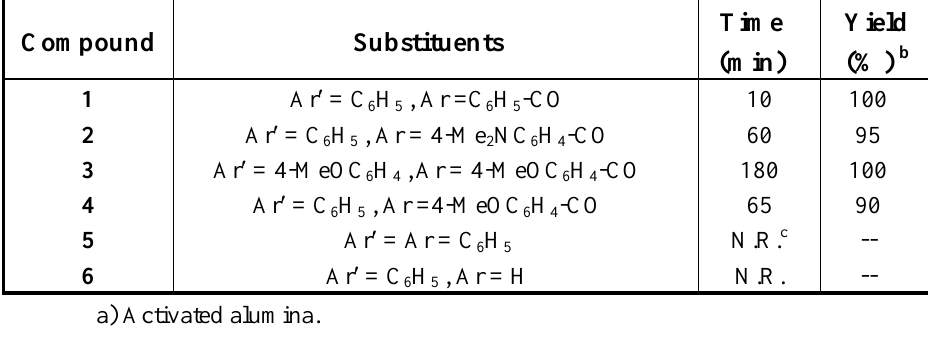
Table 1. Solid phase oxidation of benzoins on alumina a in a sand bath (140 o